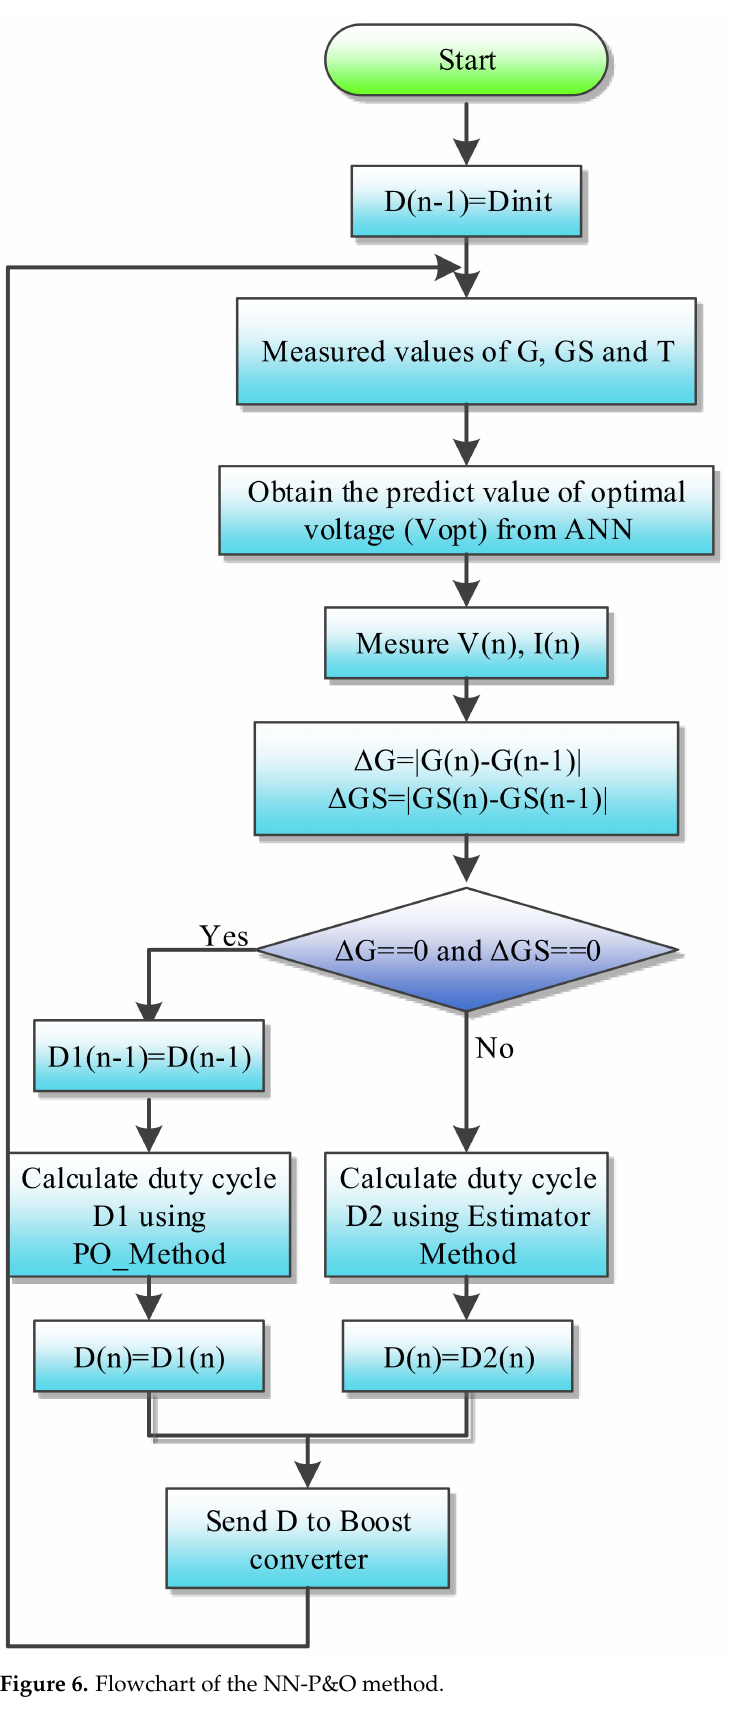
Figure 6. Flowchart of the NN-P&O